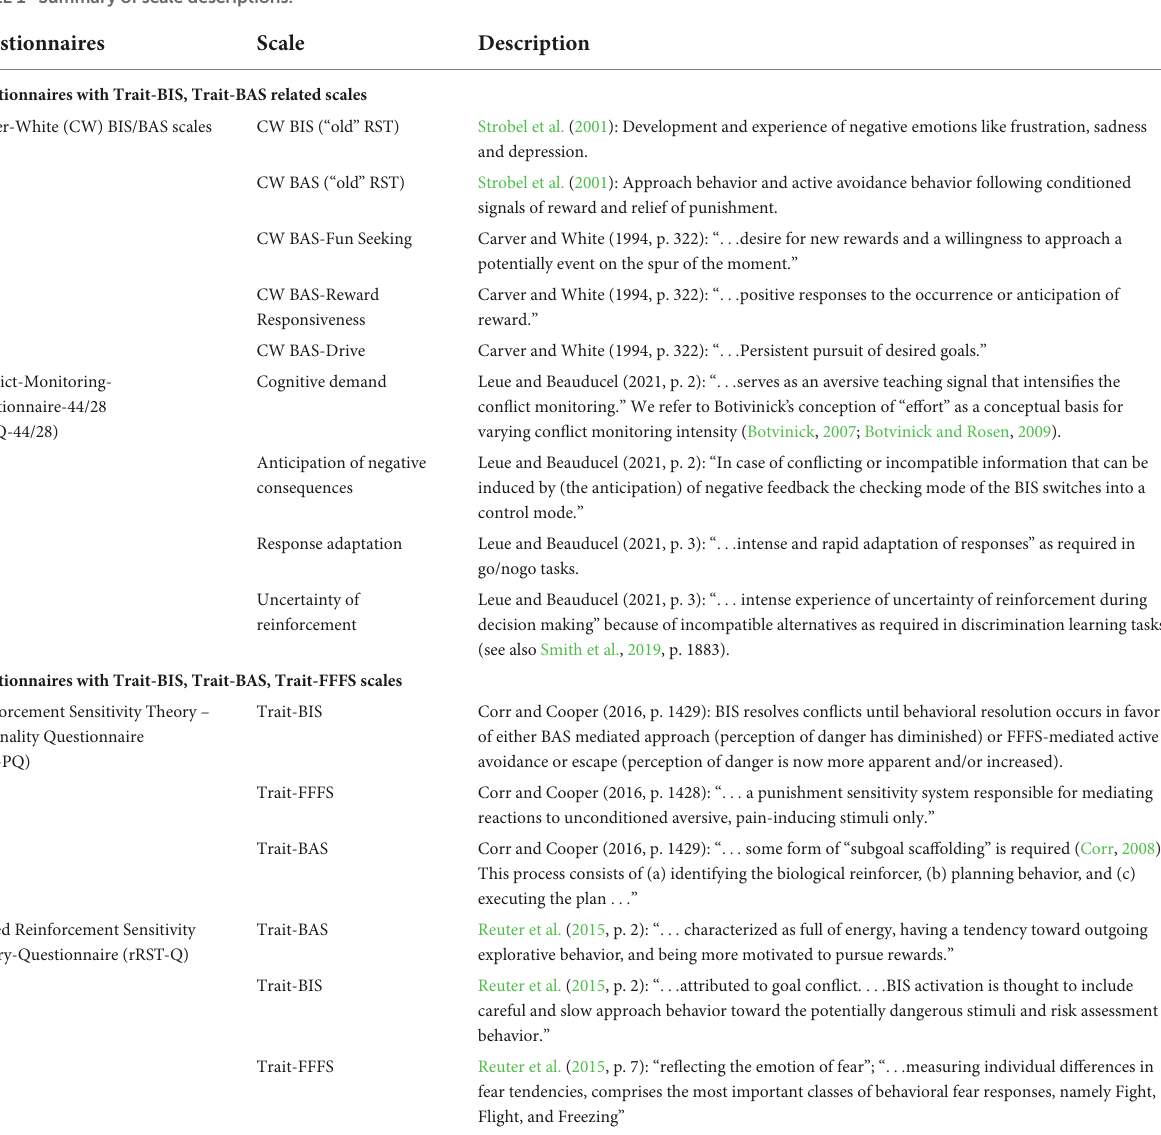
TABLE 1 Summary of scale